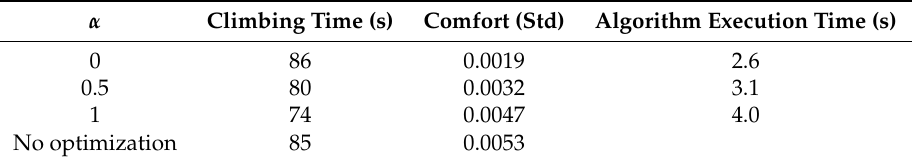
Figure 26. Path of the center of mass ( P g ) when the optimization is carried out with α equal to zero ( — ) and when the optimization is not considered ( — ). Table 6. Results obtained.